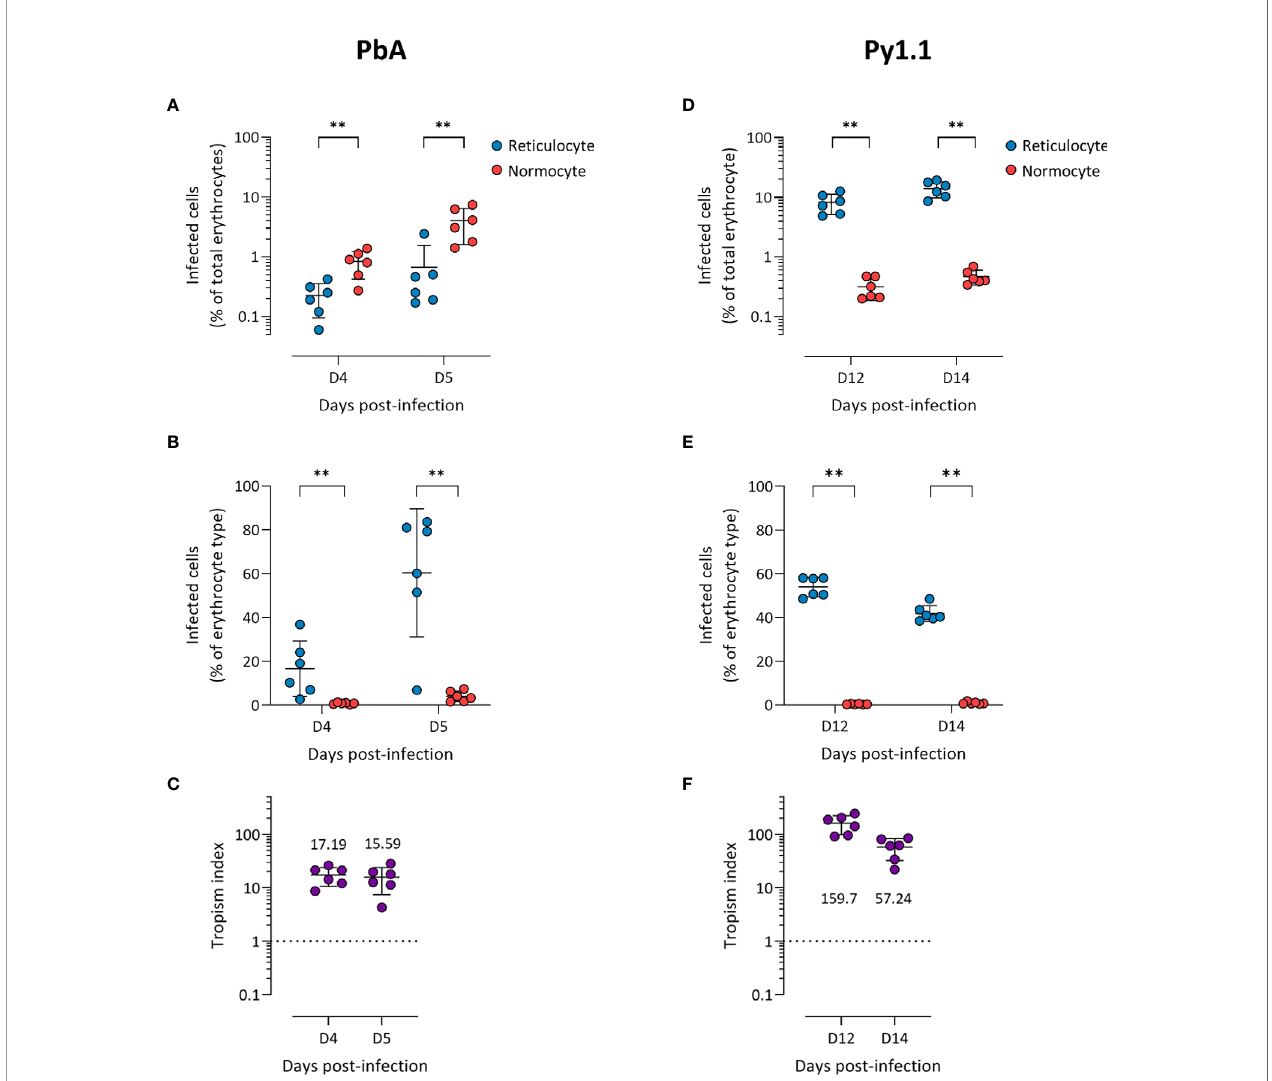
FIGURE 1 | P. berghei ANKA (A – C) and P. yoelii 17X1.1 (D – F) prefer to invade reticulocytes in vivo . Flow cytometry data of peripheral blood taken from infected mice before the peak of infection (two days shown). Reticulocytes (blue circles) and normocytes (red circles) are de fi ned as CD71+ CD98+ cells and CD71- CD98- cells, respectively. Infected cells are Hoechst-positive. (A, D) Data shown are infected reticulocytes and infected normocytes, as a percentage of total erythrocytes. (B, E) Data normalized to the relative frequencies of reticulocytes and normocytes, by expressing infected reticulocytes and normocytes as a percentage of total reticulocytes and total normocytes, respectively. (C, F) The in vivo tropism index is calculated as the ratio of percentage of infected reticulocytes (out of total reticulocytes) to percentage of infected normocytes (out of total normocytes). The mean tropism indices ( n = 6 mice) are shown. Dotted lines at tropism index = 1 represent no erythrocyte preference. All error bars are standard deviations. ** p <